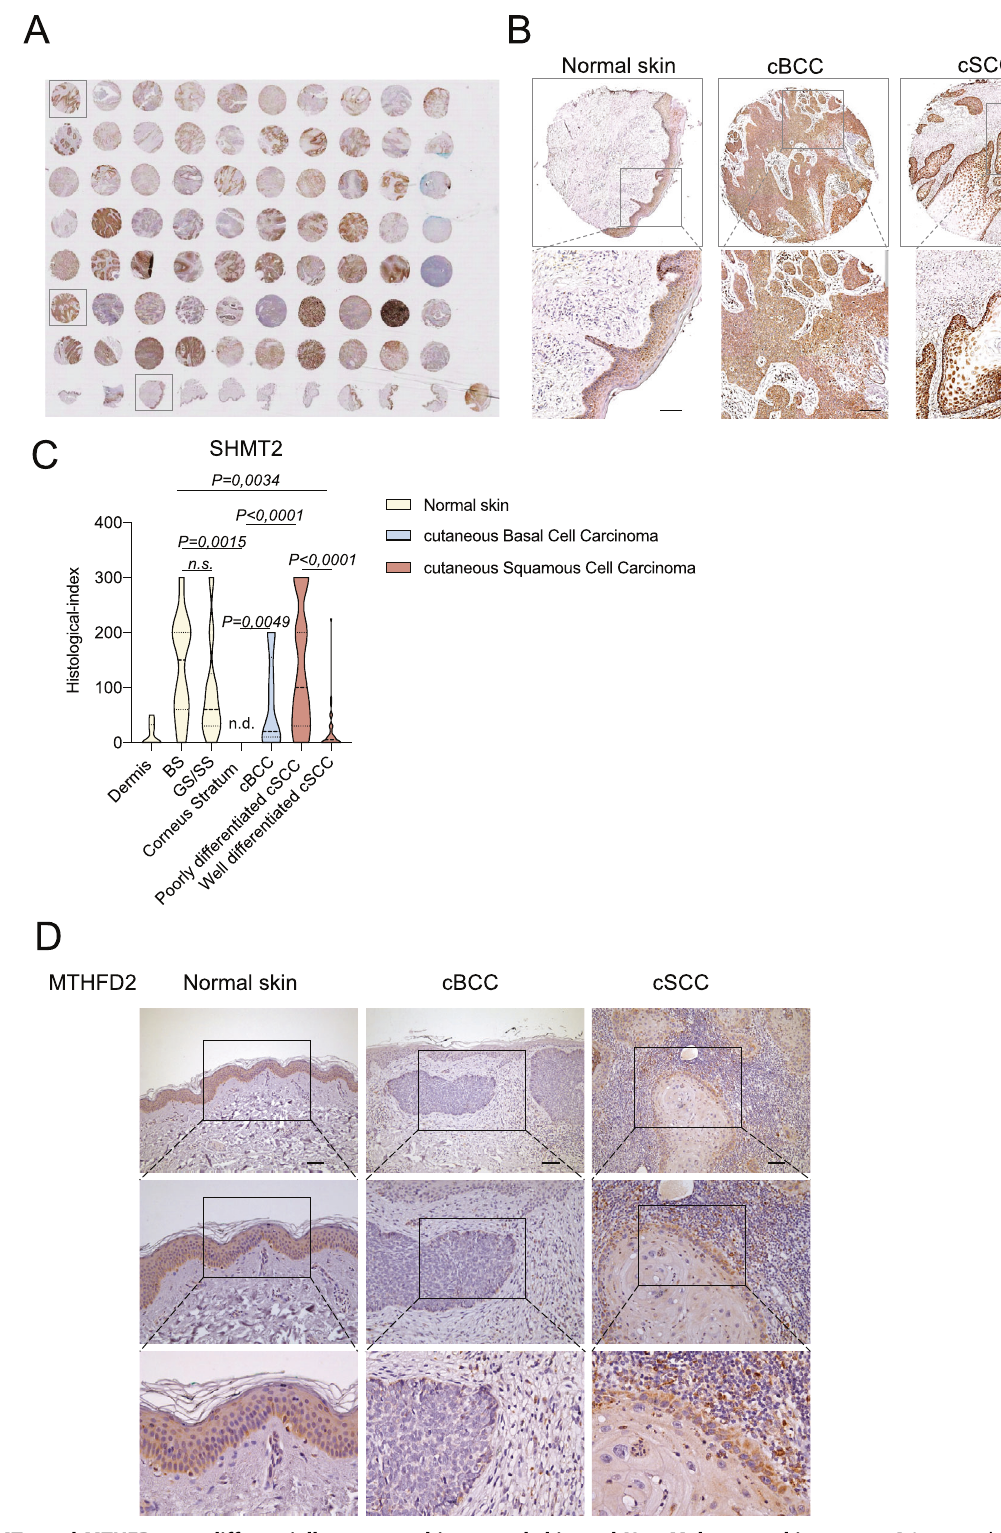
Cell Death Discovery (2023)